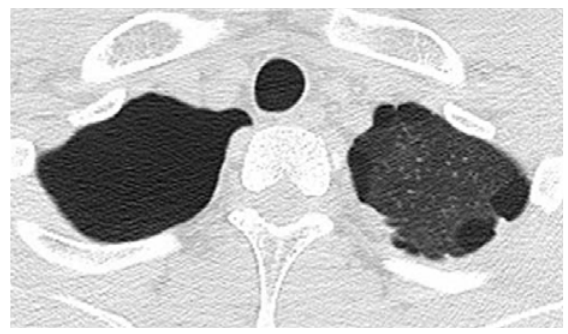
Figure 2. Chest CT showed subpleural bulla over left apical segments were found.